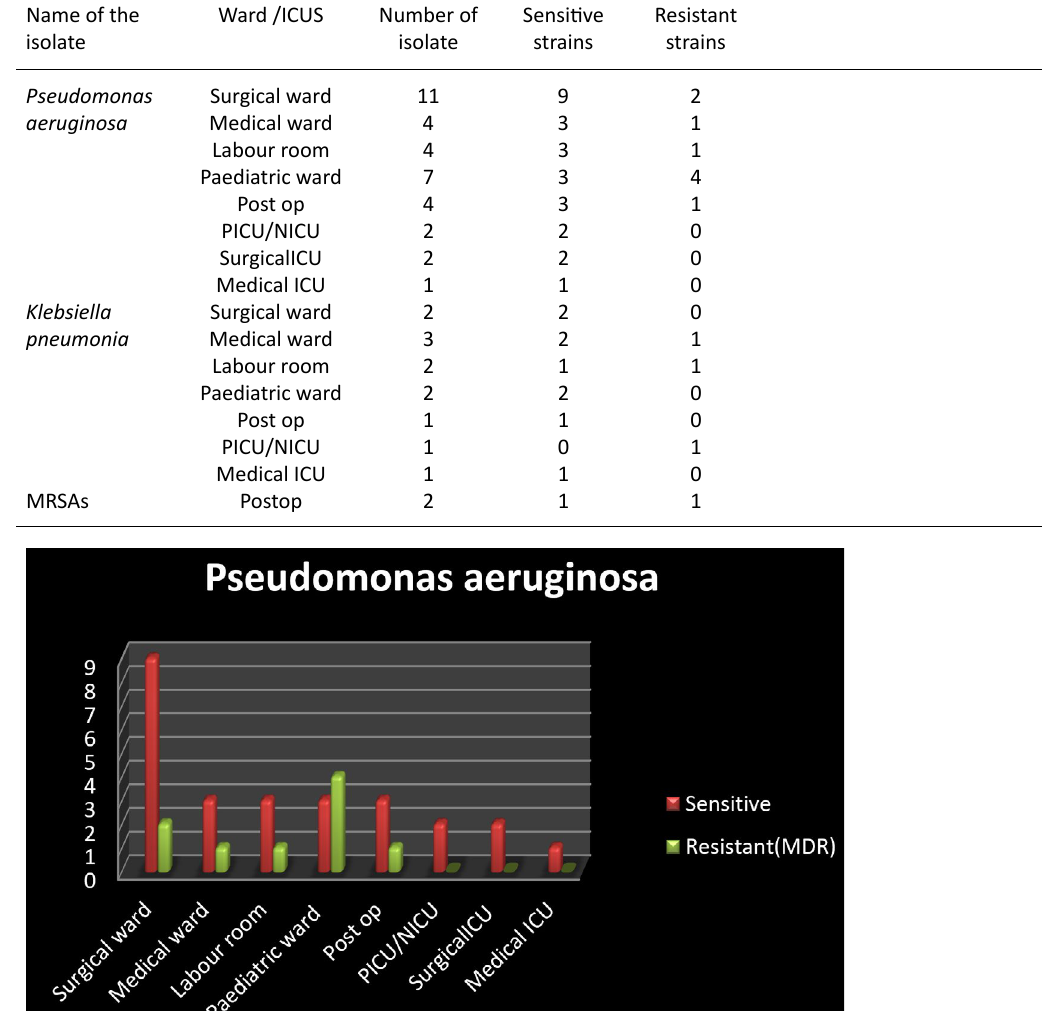
Fig 2. illustrates the sensitive strains and MDR Pseudomonas aeruginosa